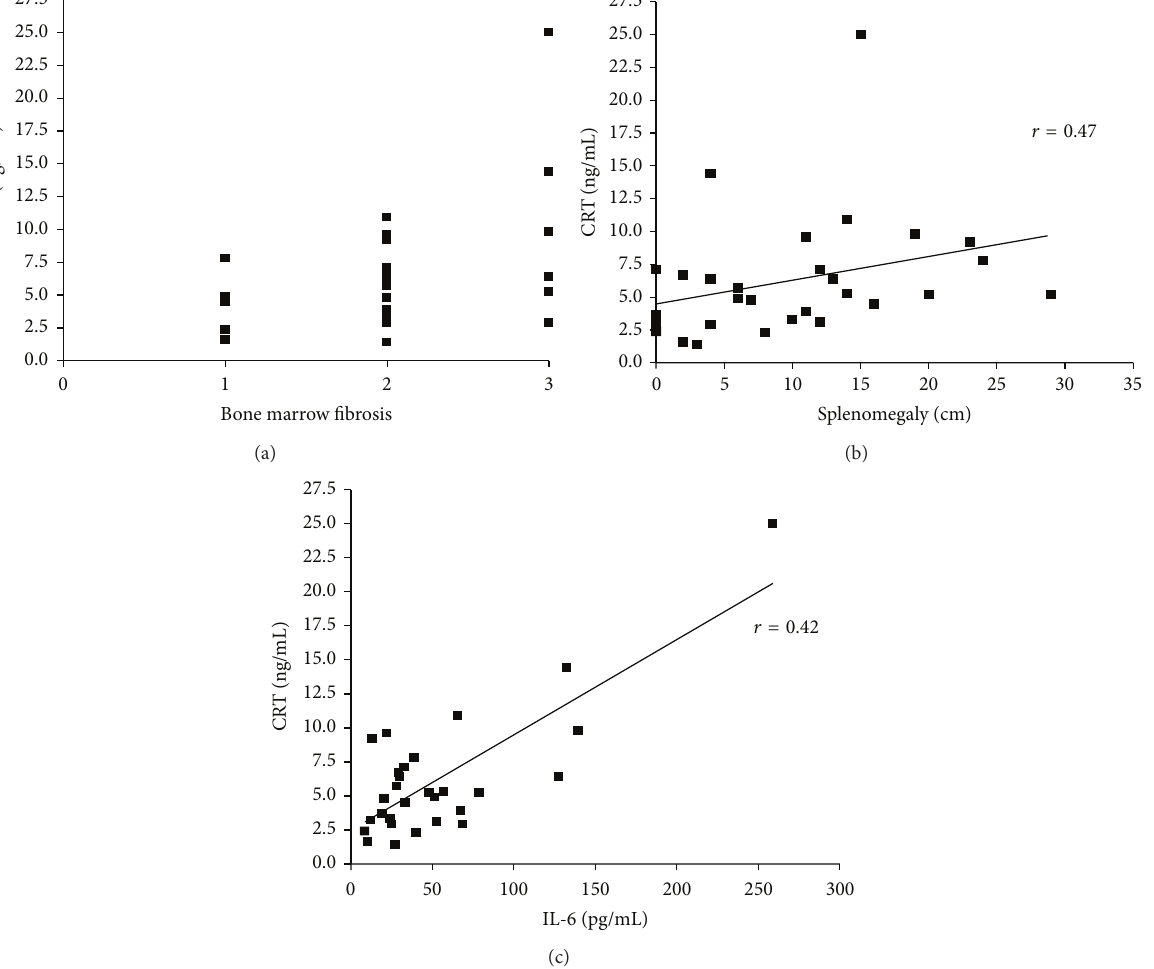
Figure 2: Correlation between CRT plasma levels and BM fibrosis, splenomegaly, and circulating IL-6 . Circulating CRT positively correlates with fibrosis, splenomegaly, and soluble IL-6 in MF. Scatterplots demonstrating correlation between the plasma levels of CRT and BM fibrosis ( 𝑝 = 0.038 ; 𝑟 = 0.39 ), splenomegaly ( 𝑝 = 0.0089 ; 𝑟 = 0.47 ), and circulating IL-6 ( 𝑝 = 0.028 ; 𝑟 = 0.42 ) in MF patients (a, b, and c, resp.) are shown. 𝑥 -axis of (a) shows BM fibrosis